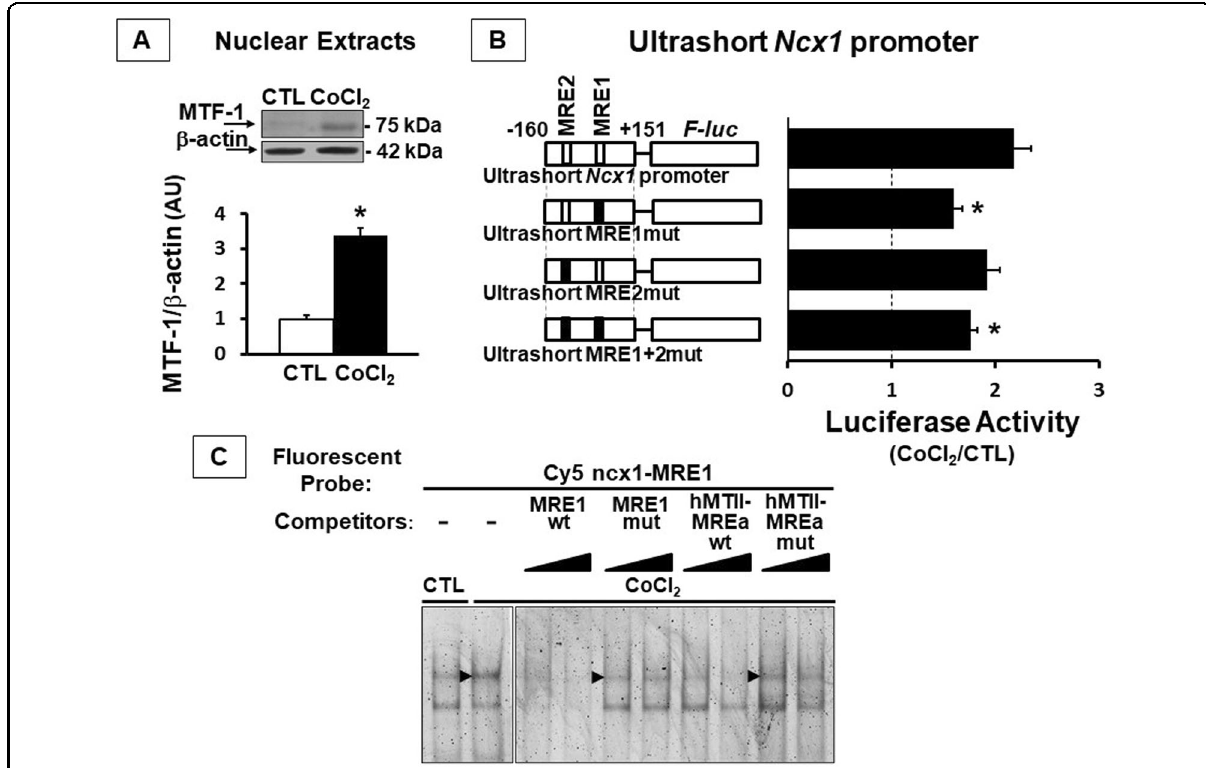
Fig. 2 MTF-1 activated the Na + /Ca 2 + exchanger brain Slc8a1 promoter. A Representative Western blot of MTF-1 in a nuclear extract from SH- SY5Y cells treated with CoCl 2 . B Luciferase assay, expressed CoCl 2 /CTL ratio, of SH-SY5Y cells transfected with ultrashort ncx1 ( − 160/ + 151) promoter or ultrashort MRE1mut or ultrashort MRE2mut or ultrashort MRE1 + 2mut, incubated with 100 μ M of CoCl 2 for 24 h. C EMSA on nuclear extracts from SH-SY5Y cells untreated (CTL; lane 1) or treated with 100 μ M of CoCl 2 for 24 h incubated with the Cy5-tagged ncx1-MRE1 probe (CoCl 2 ; lanes 2/10). Competition experiments were performed with increasing quantities (50× and 100×) of: the unlabeled wild-type MRE1 (ncx1-MRE1 wt; lanes 3 – 4); the mutant MRE1 (ncx1-MRE1 mut; lanes 5 – 6); the wild type MRE of the Homo Sapiens metallothionein II gene (hMTII-MREa wt; lanes 7 – 8); and the mutant metallothionein II MRE (hMTII-MREa mut; B, lane 4) oligonucletides. * p < 0.05 vs. ultrashort ncx1 ( − 160/ + 151) promoter by one-way ANOVA followed by Bonferroni test. Each column represents the mean ± SEM of 4/9 independent experimental sessions, each one run in